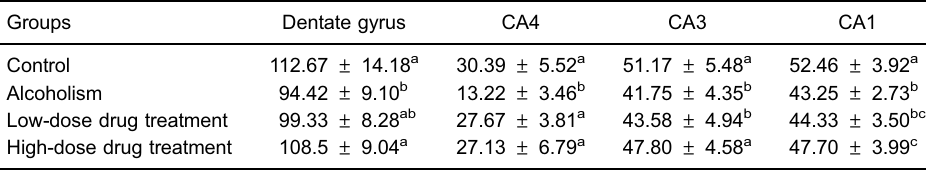
Table 1. Number of brain-derived neurotrophic factor (BDNF)-positive neurons in the dentate gyrus and hippocampus (CA4, CA3, and CA1) in the four groups. Groups